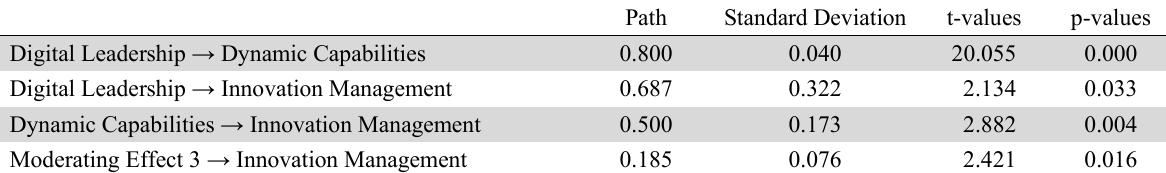
Partial Hypotheses Testing